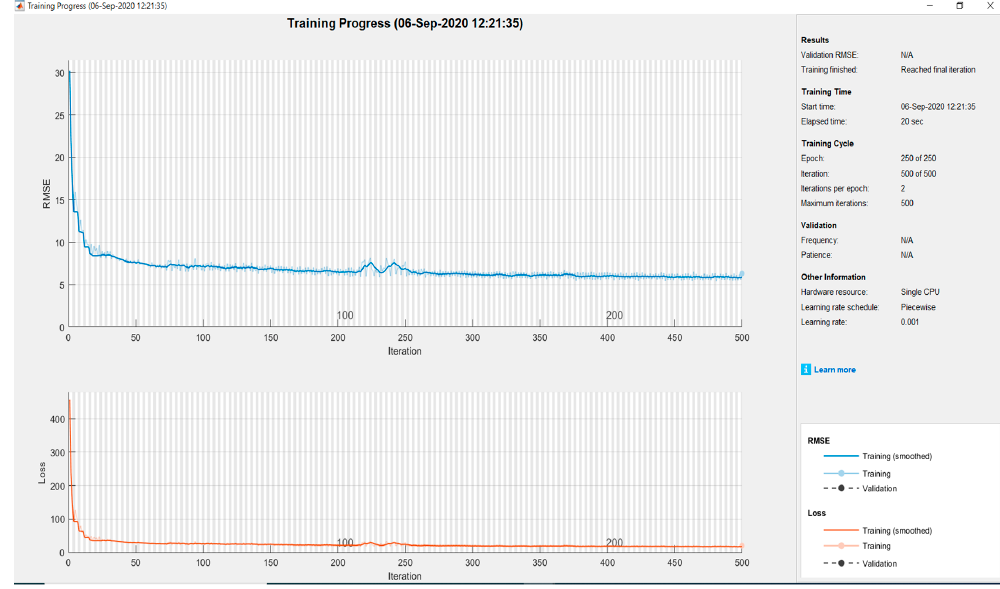
Figure 5. LSTM model training.